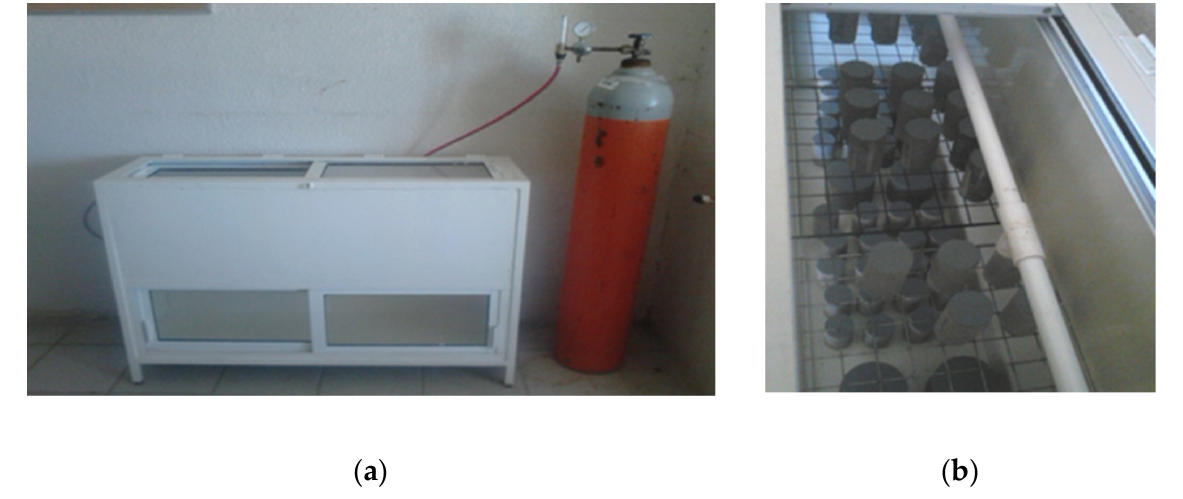
Figure 1. ( a ) Accelerated carbonation chamber, ACC. ( b ) Samples distribution in ACC.